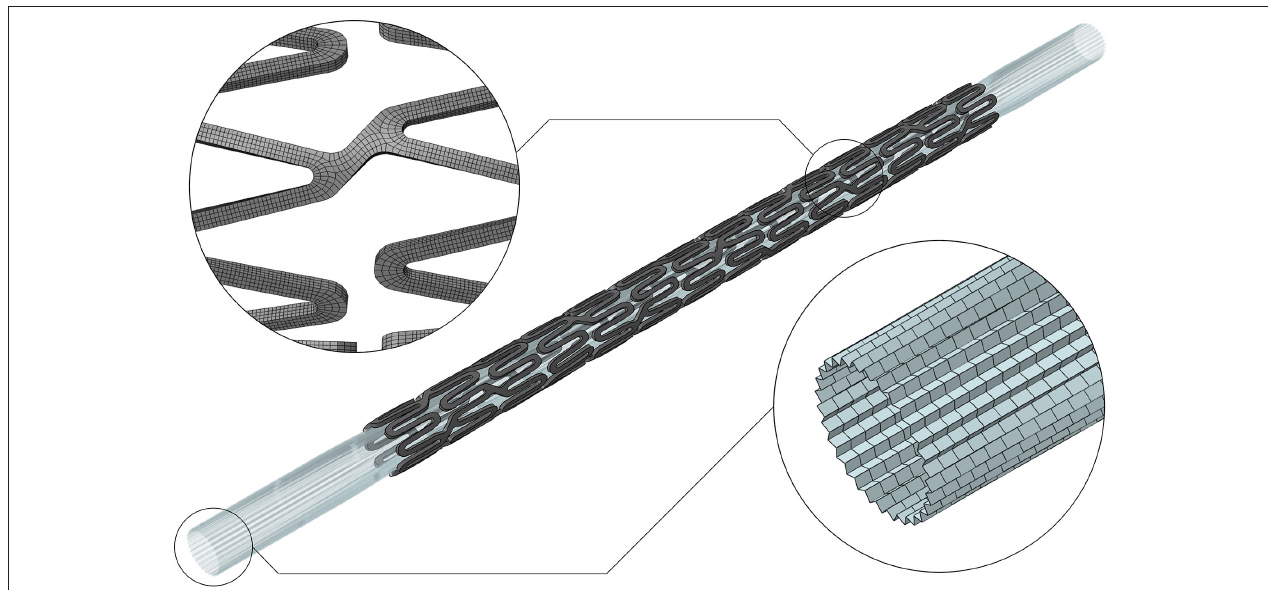
FIGURE 1 | Digital twin of the SYNERGY TM BP delivery system, with a detail of the mesh refinement of the stent and balloon